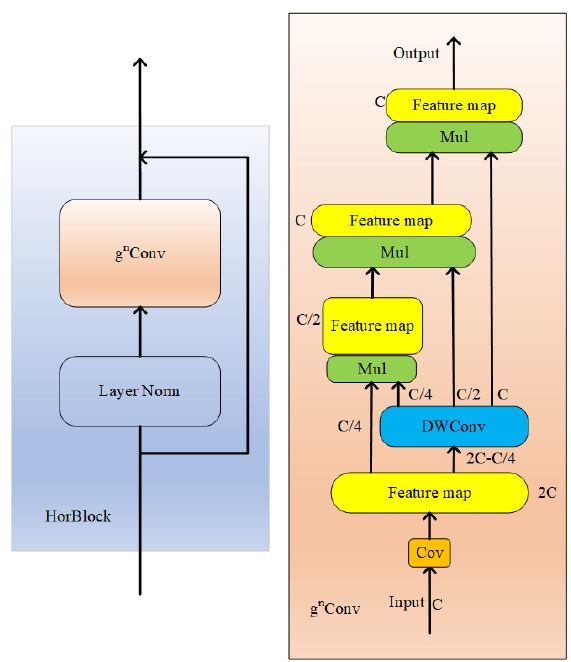
Figure 6. The schematic diagram of